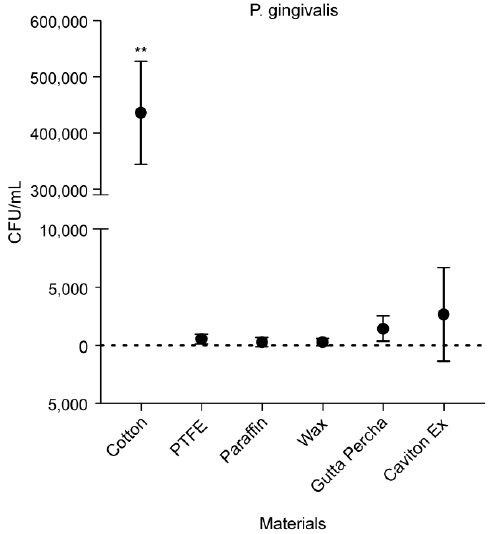
Figure 7. Colony forming units per mL of P. gingivalis adhesion against different materials. Data are expressed as mean ± standard deviation ( n = 8; ** p < 0.01). Similar to P. gingivalis adhesion, there were significant differences between the adhe- sion of cotton (average count of 65,025 CFU/mL; p < 0.01) and of all the other materials to F. nucleatum (Figure 8). PTFE, PF, wax, GP, and CE showed average F. nucleatum counts of 4513, 4575, 13,025, 11,325, and 32,225 CFU/mL, respectively. Evidently, CE’s F. nuclea- tum counts were significantly higher ( p < 0.01) than that with all the other materials, except for cotton. Figure 8. Colony forming units per mL of F. nucleatum adhesion against different materials. Data are expressed as mean ± standard deviation ( n = 8; ** p < 0.01).